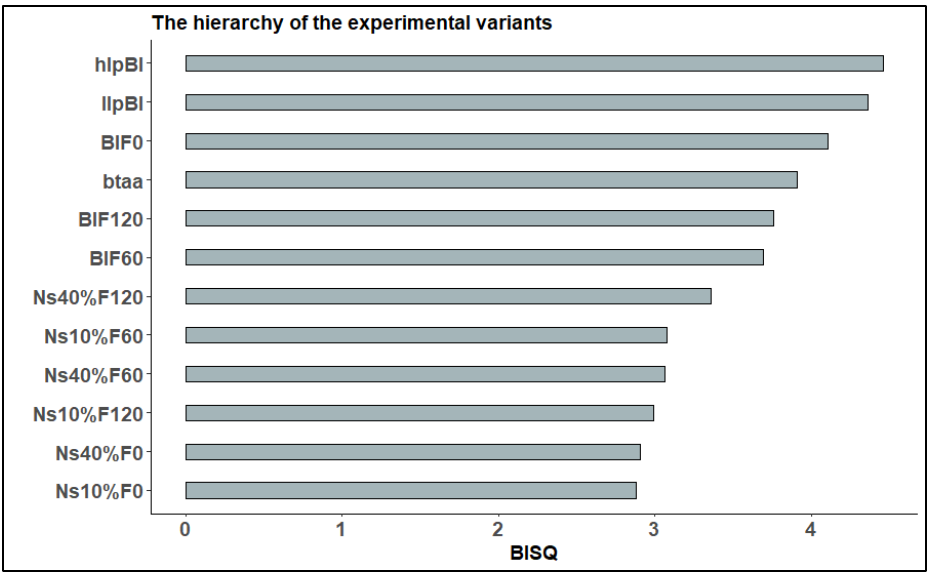
Figure 2. The Pearson correlation computed for the six microbial groups identified in the 12 experimental variants.